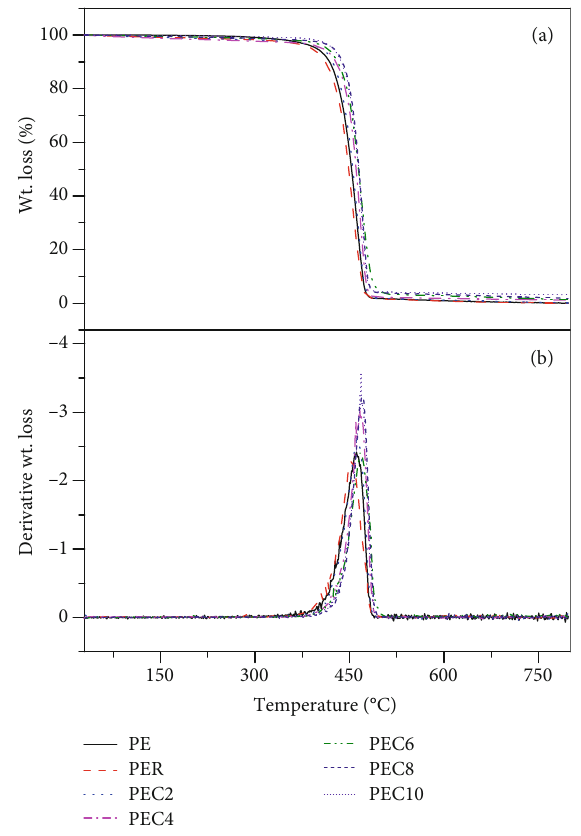
Figure 11: (a) Percent and (b) derivative weight loss of the polymer and composites. Table 3: Onset degradation temperature, maximum degradation temperature, and % residue at 600 ° C as extracted from TGA